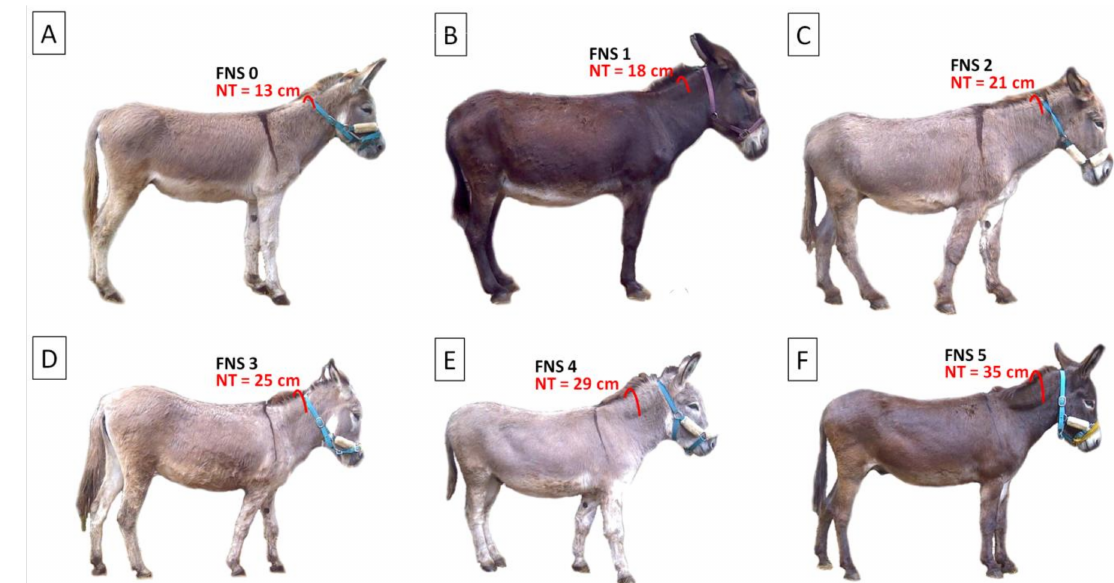
Figure 1. An example of donkeys classified following the fatty neck score (FNS): ( A ) FNS 0, ( B ) FNS 1, ( C ) FNS 2, ( D ) FNS 3, ( E ) FNS 4, and ( F ) FNS 5 categories. The red line indicates measurement of the neck thickness (NT), from one side of the neck to the other at 0.50 of the neck length, taken from the point of the estimated differentiation between the crest and the neck musculature. NT values for individuals are given in